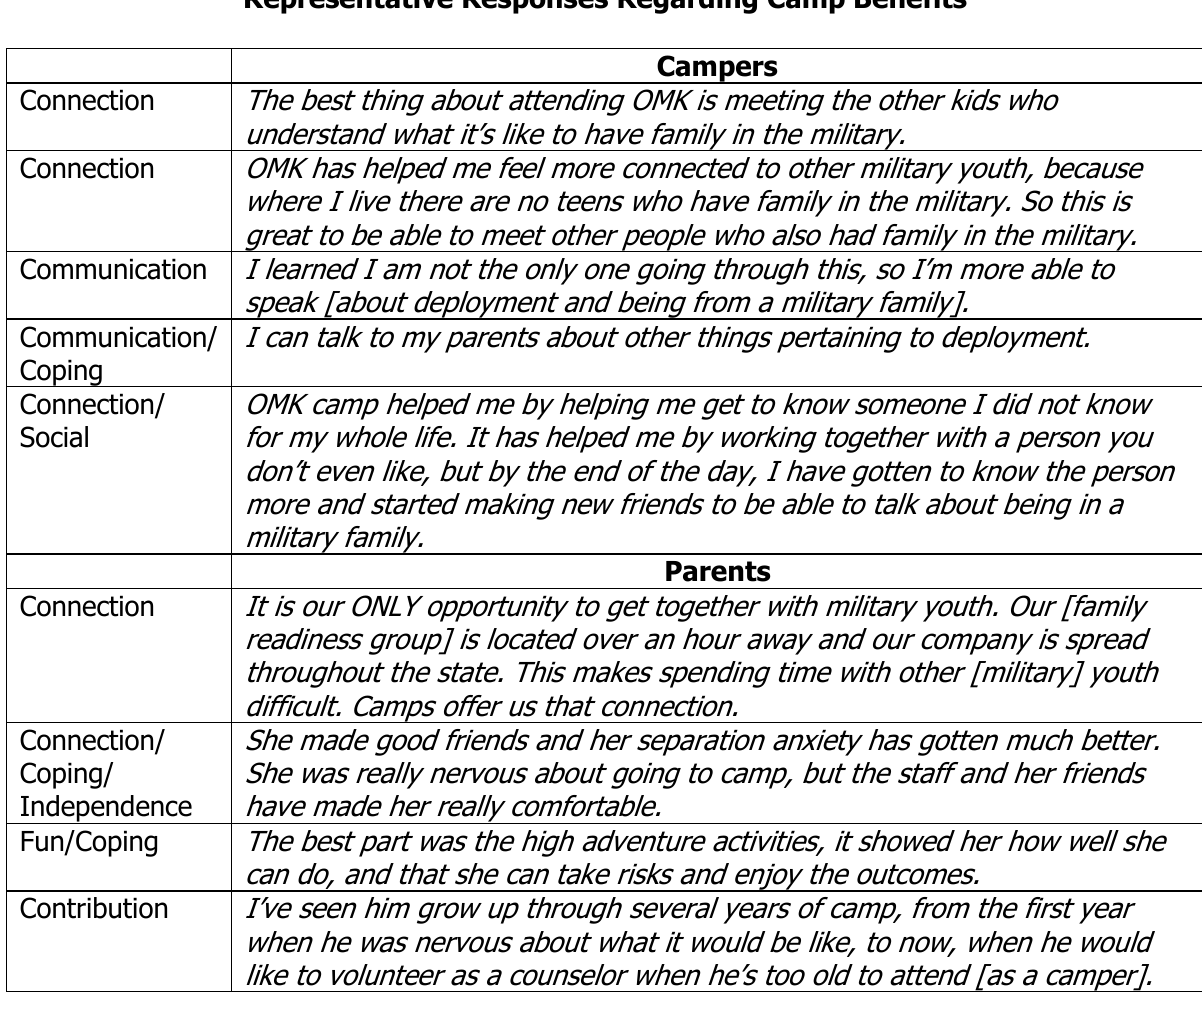
Table 6 includes some representative quotes regarding camp